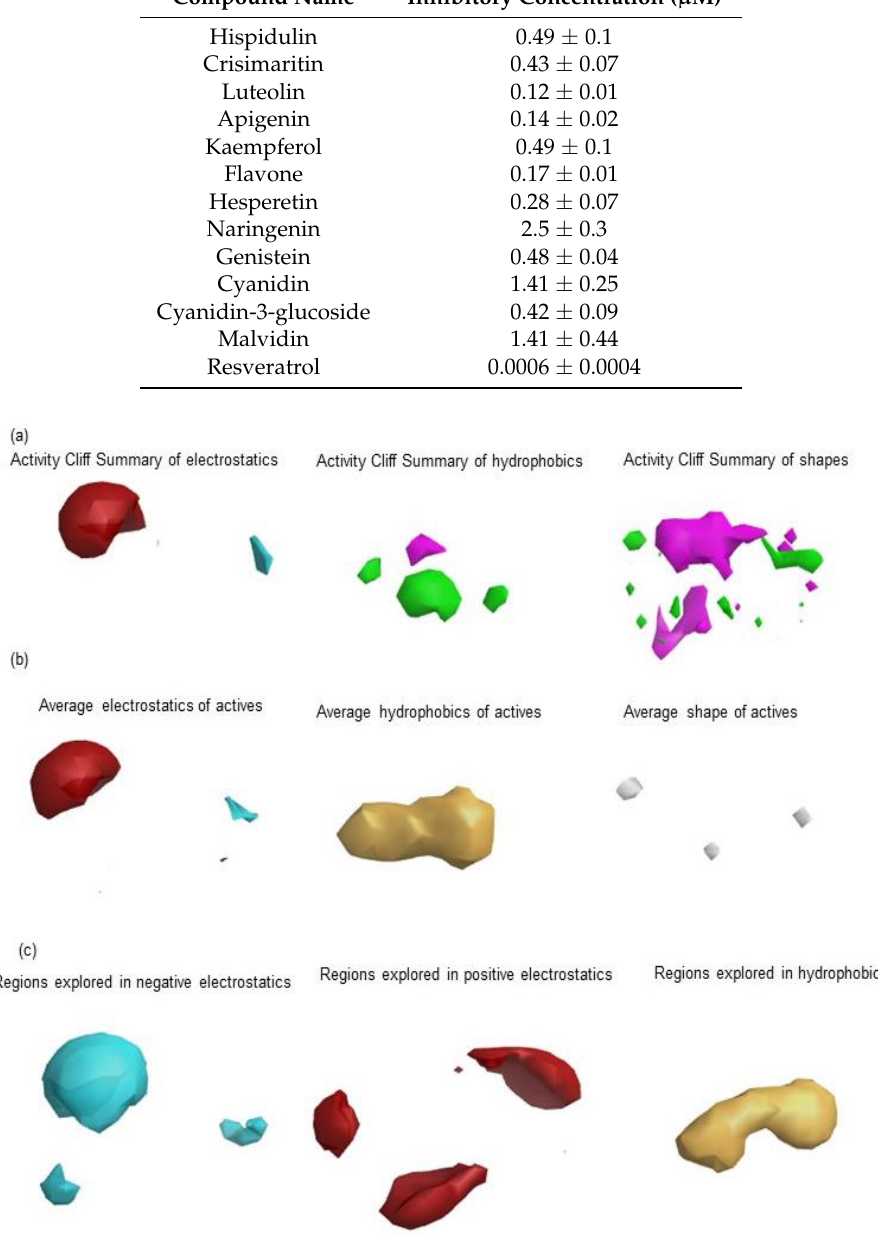
Figure 2. Activity atlas model generated based on the alignment of 13 polyphenols to generated field template which provides: activity cliff summary ( a ); average of actives ( b ); and regions explored ( c ). Forge visualization is used to understand the activity atlas and structure–activity relationship (SAR) of different natural compounds already proven to inhibit dipeptidyl peptidase-4 activity.